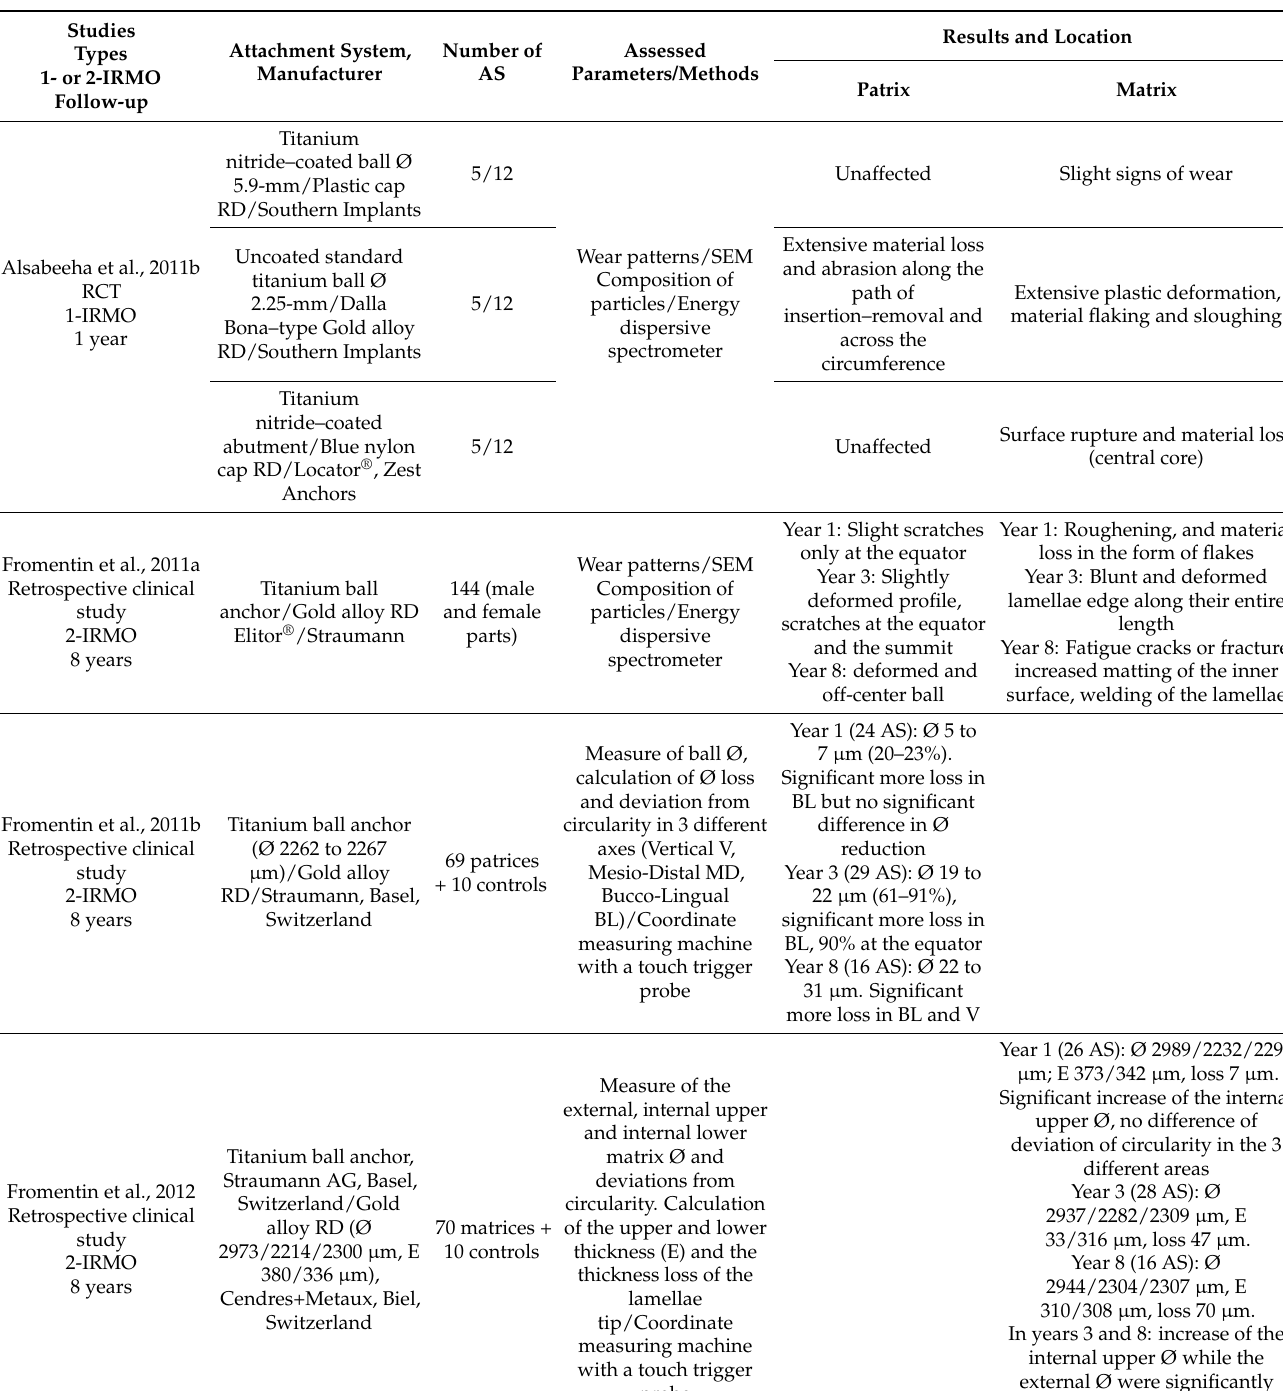
Table 3. Wear patterns and dimensional changes of ball and cylindrical attachment systems in clinical and in vitro studies. Abbreviations: RCT, randomized clinical trial; SEM, scanning electron microscope; Ø,